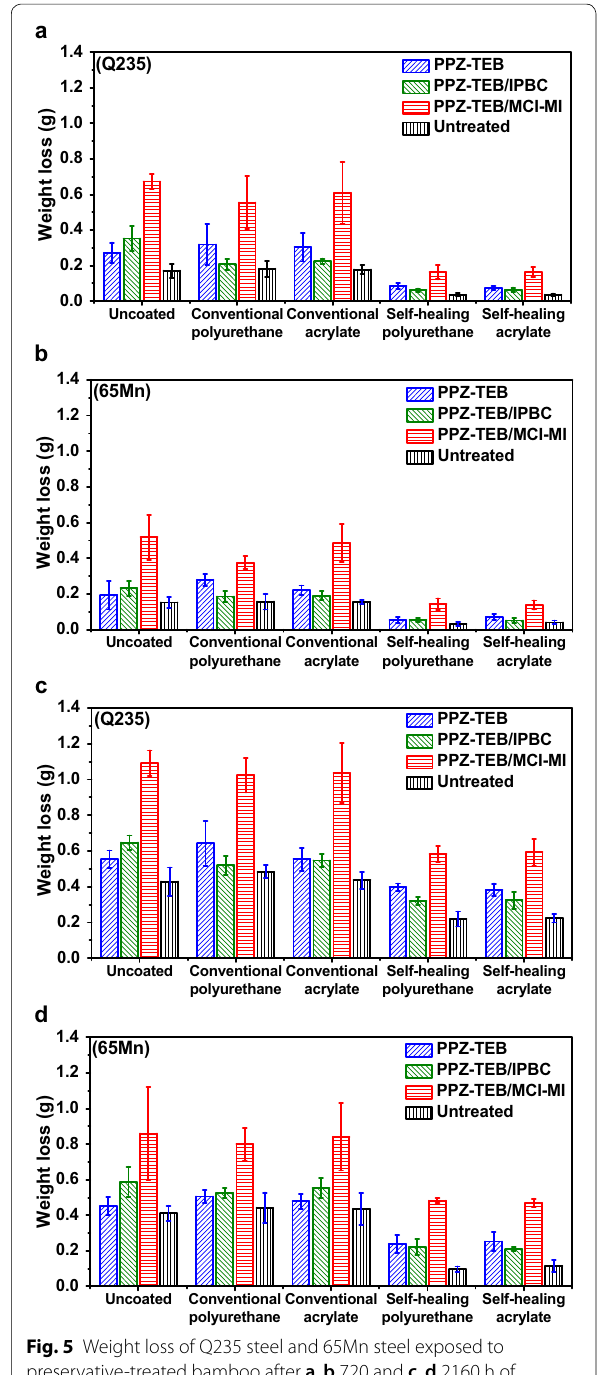
Fig. 5 Weight loss of Q235 steel and 65Mn steel exposed to preservative-treated bamboo after a , b 720 and c , d 2160 h of accelerated corrosion. Error bars represent the standard